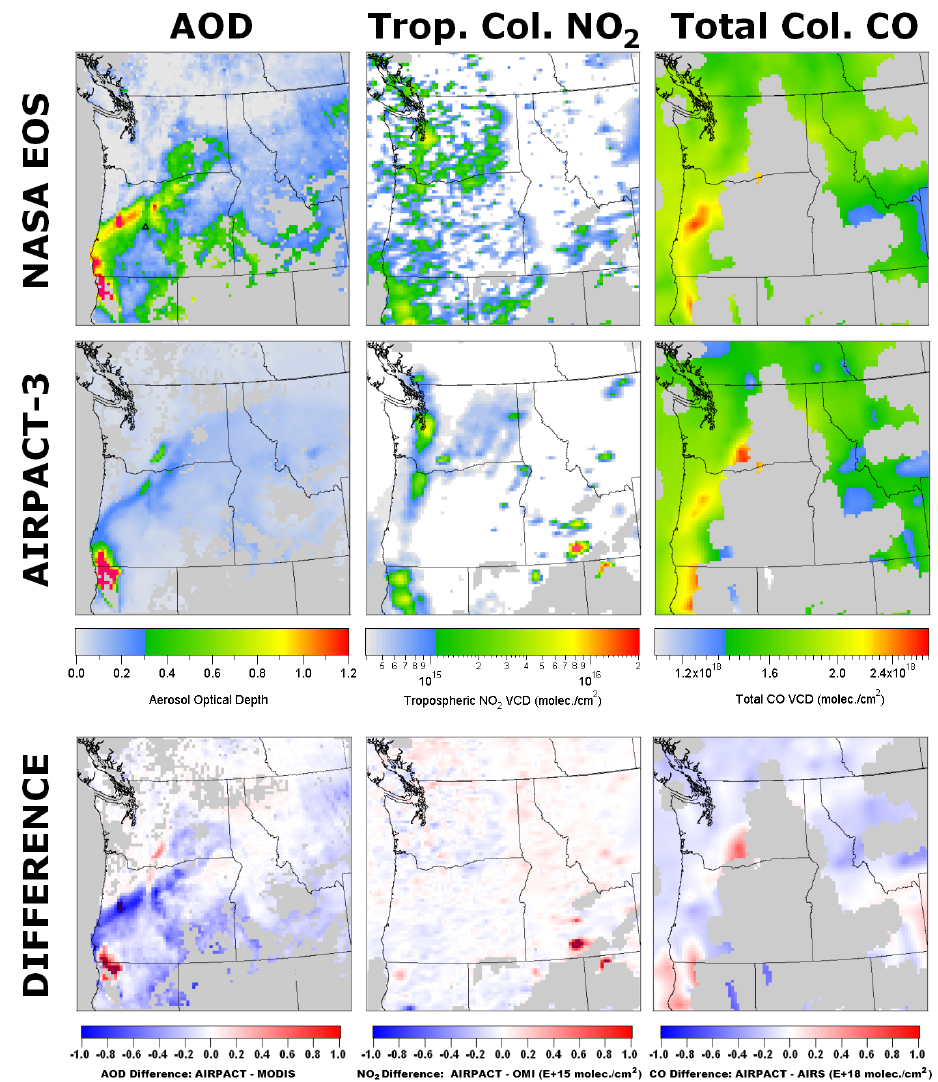
Figure 6. AOD (left column), tropospheric NO 2 columns (middle column), and total carbon monoxide columns (right column) for 20 July 2008 ( ∼ 2p.m.LST) with NASA EOS retrieval (top row), AIRPACT-3 with SMOKE plume rise (middle row), and differences (bottom row). Gray color indicates no or low-quality data from the satellite retrieval and exclusion from analysis. Values greater than the color scale maximum are shown as pink in the AIRPACT-3 and NASA EOS maps. Values outside the range of the difference color scales are shown as saturated blue/red. Mt. Bachelor is shown as a black triangle near central